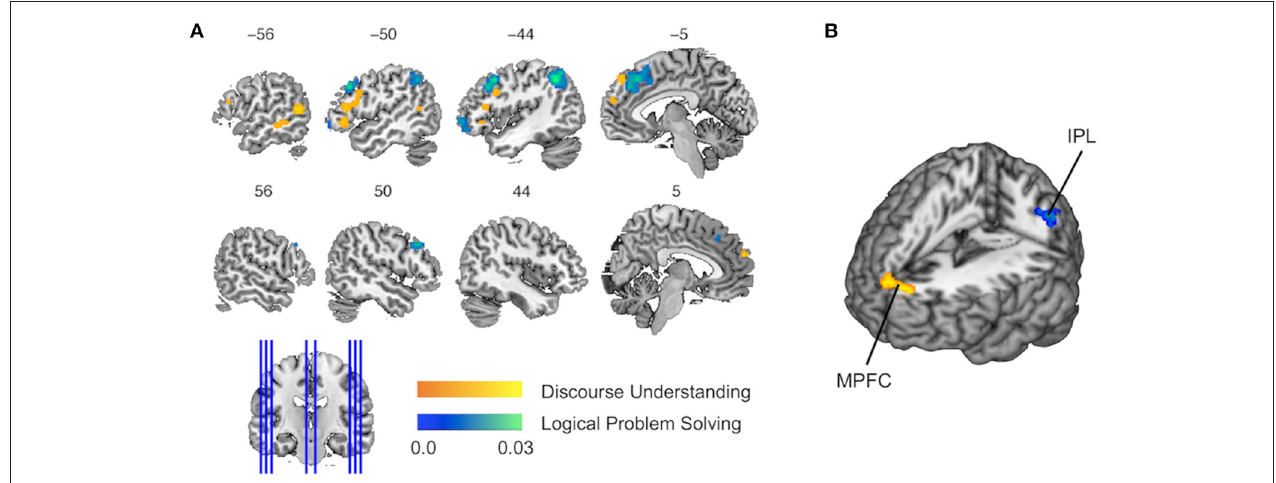
FIGURE 2 | Results of single data set analyses and contrast data sets analysis. (A) The activation likelihood estimation (ALE) maps show the significant activations associated with discourse inferences (in orange) and logical inferences (in blue). (B) The contrast map shows the activation for the contrast of discourse inferences vs. logical inferences (in orange) and the activation for the reverse contrast (in blue). MPFC, medial prefrontal cortex; IPL, inferior parietal lobule.